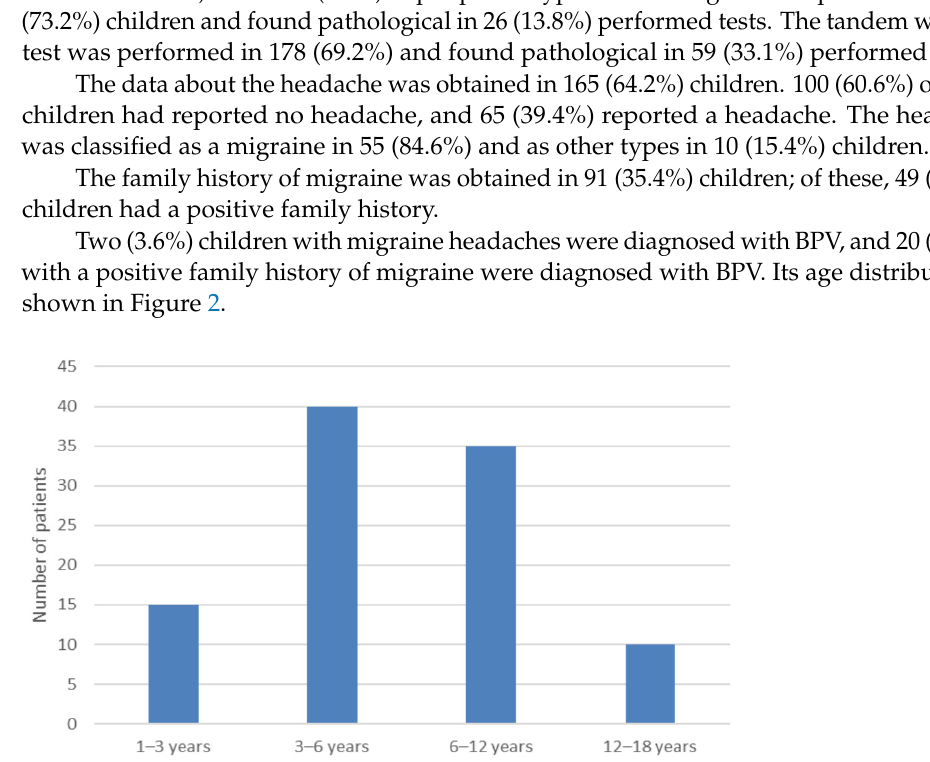
Figure 2. Age distribution of benign paroxysmal vertigo of childhood (BPV). None under 1-year-old was diagnosed as BPV.